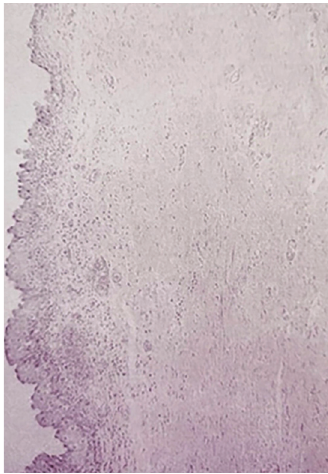
Figure 3 - early BAMA augmented bladder (12